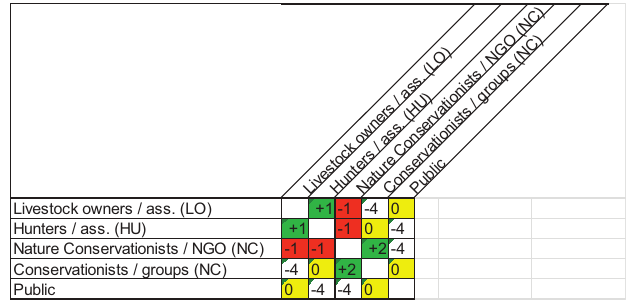
TABLE 2 | Model socio-matrix based on the model stakeholder map (see Figure 2 ).